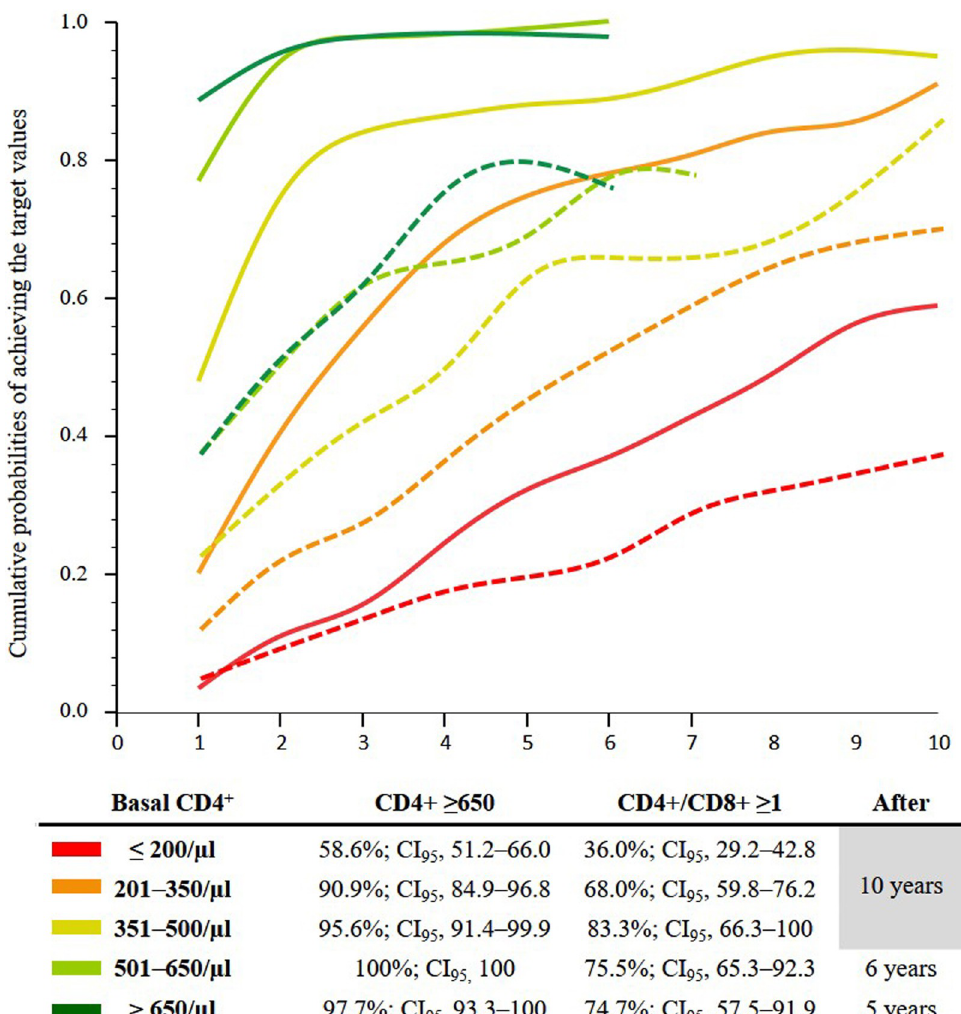
Fig 1. Cumulative probabilities of achieving a CD4 count � 650/ μ l (continuous lines) and a CD4/CD8 ratio � 1 (dashed lines) after starting antiretroviral therapy as function of CD4 counts at baseline. � the values for patients who started treatment with absolute CD4 between 500 and 650/ μ l and > 650/ μ l were displayed up to 6 and 5 years of follow- up, respectively, as the number in these groups decreased to less than 10 patients from these points on.